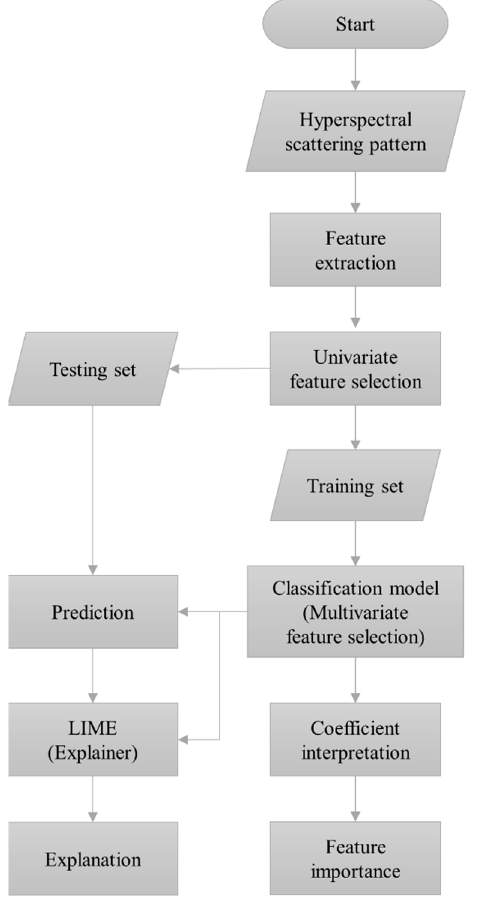
Figure 2. A flowchart illustrating the feature processing methodology for the classification of hy- perspectral ELS patterns. Univariate and multivariate feature selection techniques were utilized to alleviate the burden of high feature dimensionality, which increases the computational cost of classification and increases the likelihood of